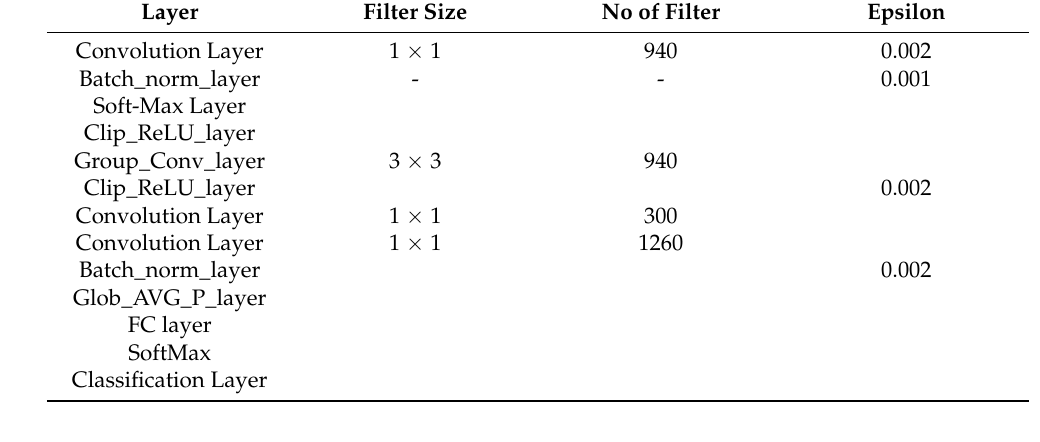
Table 2. The specifications of the layers in the proposed learning model, GN-AlexNet.